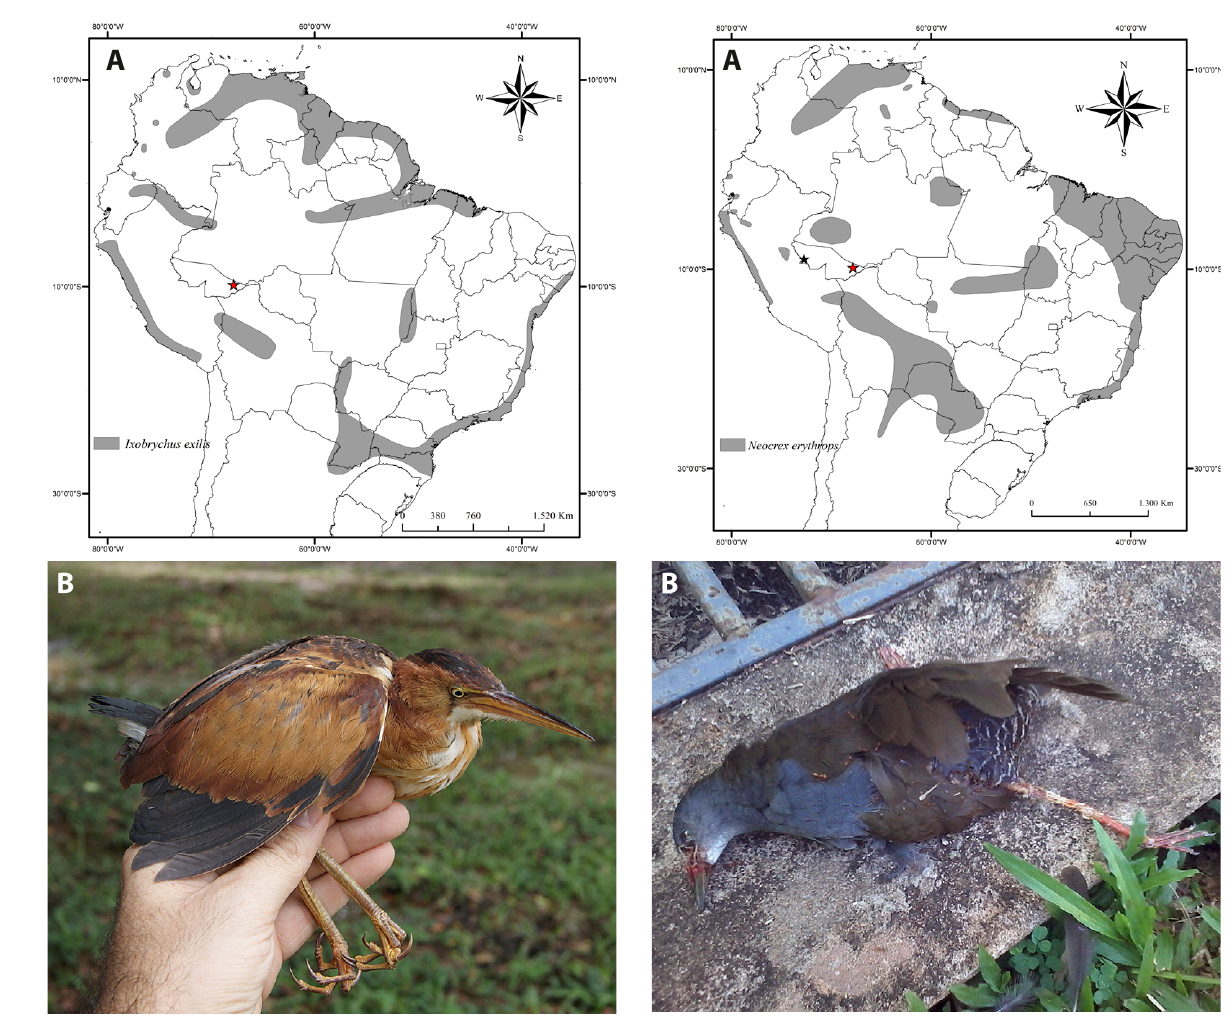
Figure 1. Least Bittern ( Ixobrychus exilis ). A. Range (grey) in South America. B. Documented record of the species presented in this study (red star). Photo by Edson Guilherme.